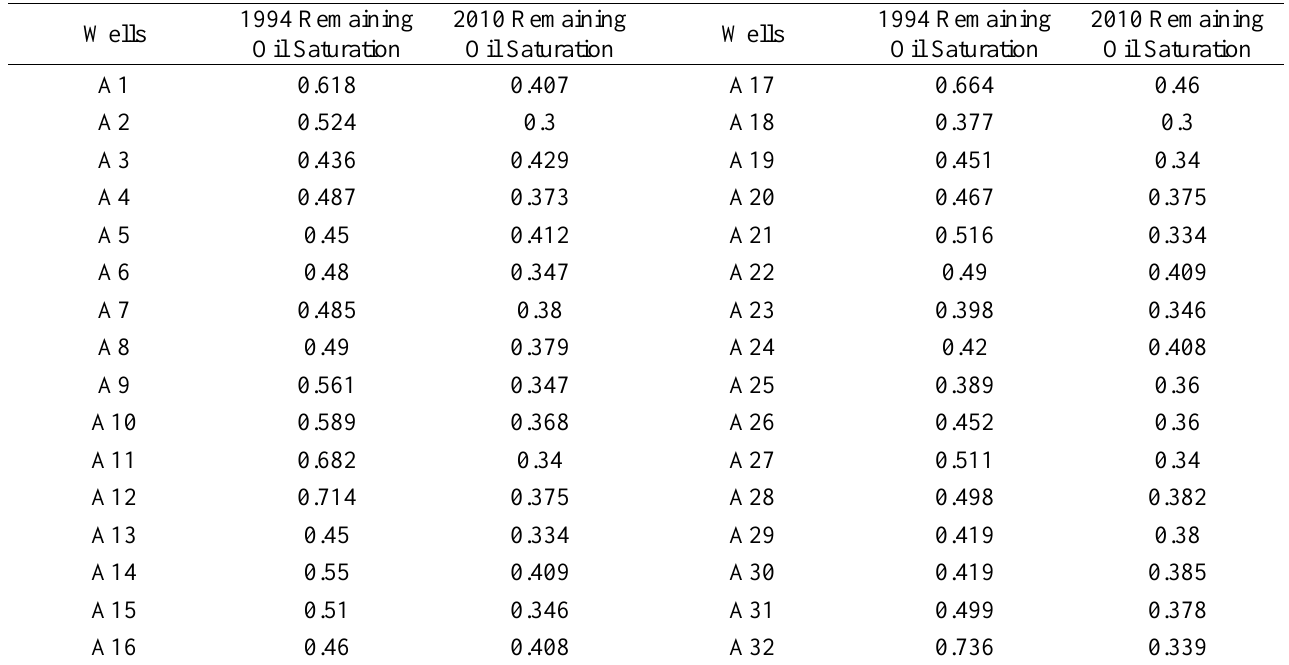
Table 3—Comparison between current remaining oil value and initial measured